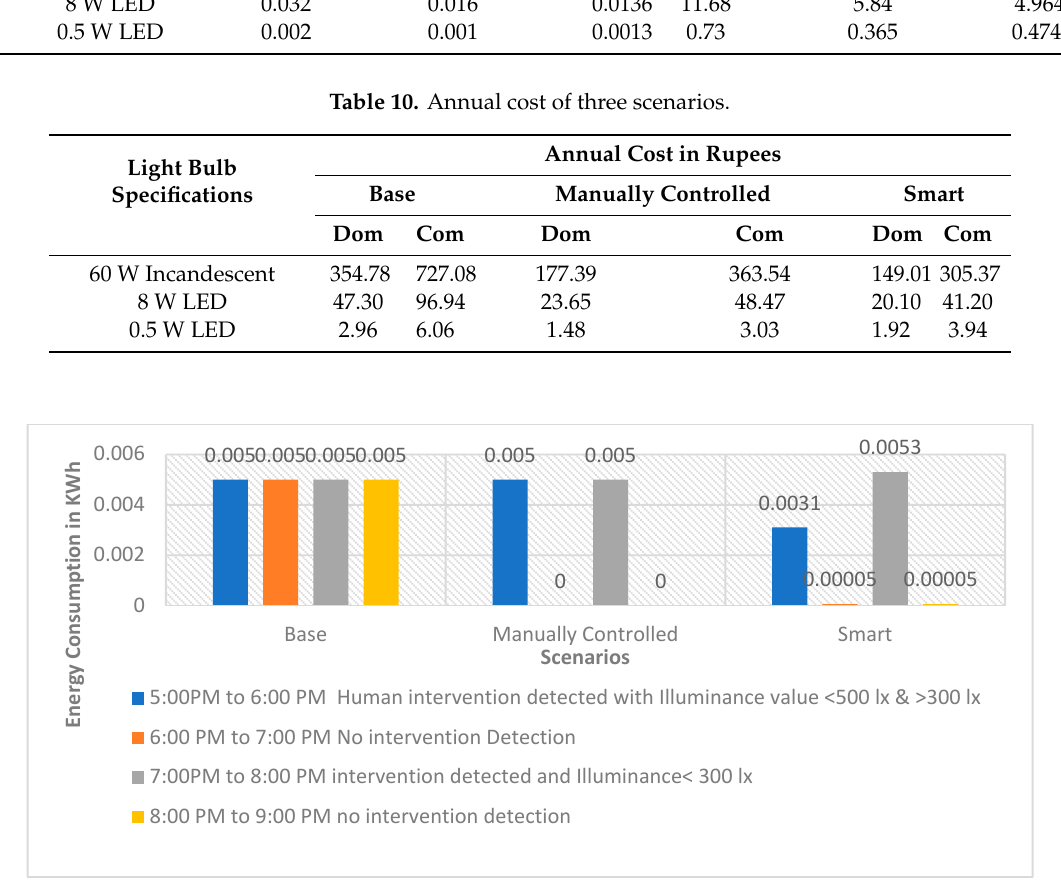
Figure 6. Graph for energy consumption of a 0.5 W LED light bulb in three scenarios. Sensors 2019 , 19 , x FOR PEER REVIEW